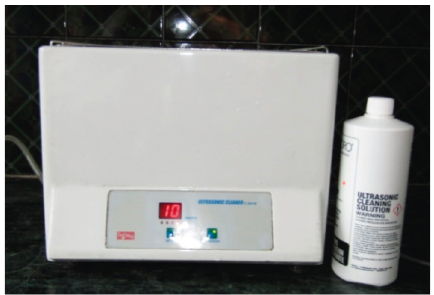
Figure 3: Ultrasonic cleaning of brackets.